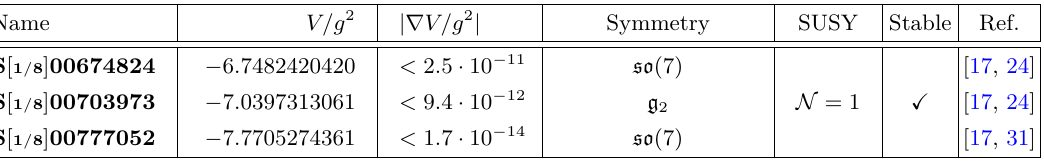
Table 1. Summary of vacua at ω = π/ 8